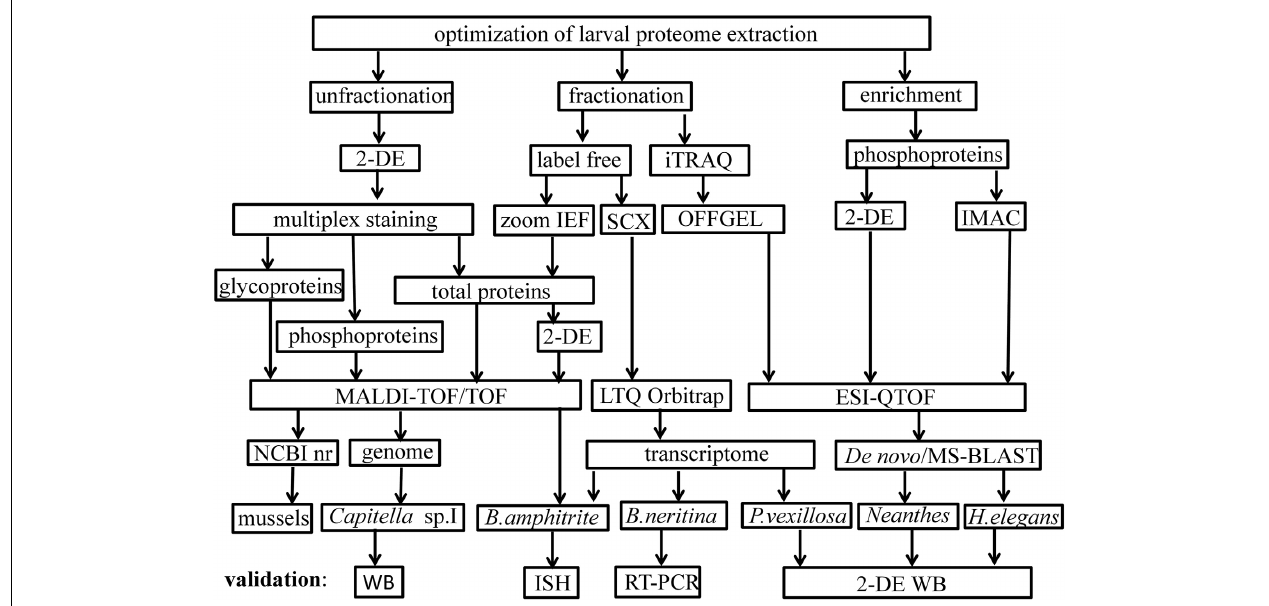
FIGURE 1 | Proteomics tools used to study marine larvae. Abbreviations: 2-DE, two-dimensional-gel electrophoresis; iTRAQ, isobaric tags for relative and absolute quantitation; IEF, isoelectric focusing; SCX, strong cation exchange; IMAC, immobilized metal ion affinity chromatography; MALDI-TOF,